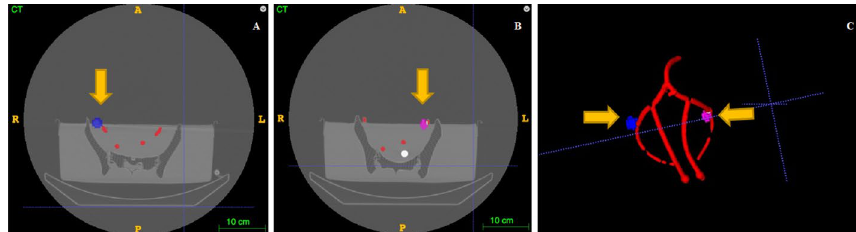
Fig. 4 Registration of SPECT/CT and CT images using itk-SNAP ® 3.6.0. The fusion CT image with the right